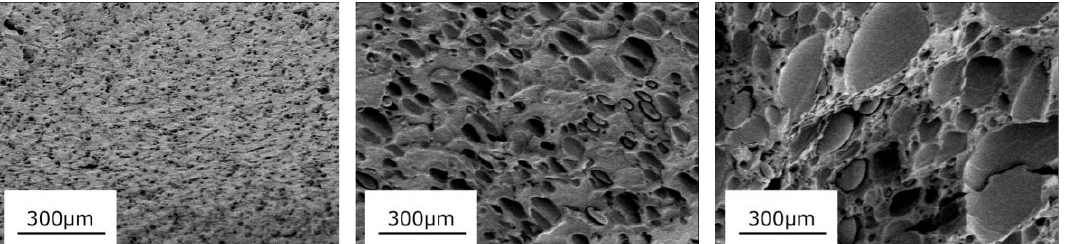
Figure 1. SEM images of the fractured surfaces of compression-molded films; ( left ) PC/LDPE (97/3), ( center ) PC/LDPE (90/10), and ( right ) PC/LDPE (75/25).